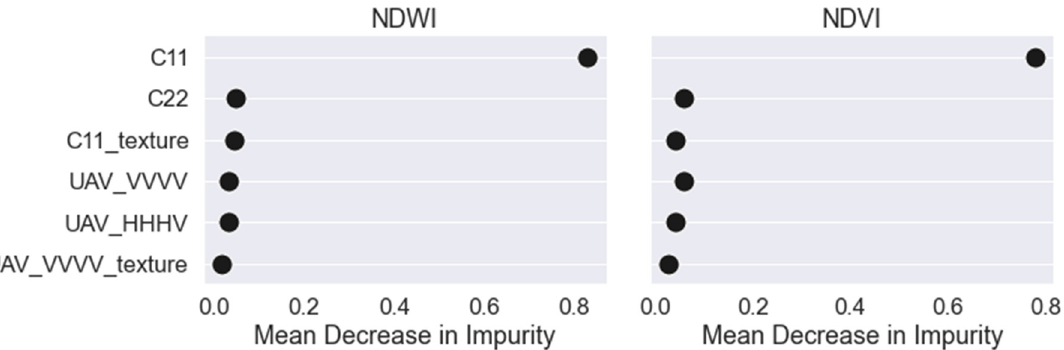
Figure 7. Mean Decrease in Impurity (MDI) for each of the variables used in the random forest model with de-noised Sentinel-1 and UAVSAR. The C11 band (obtained from VH-polarization) was found to be the most important band compared with the rest.